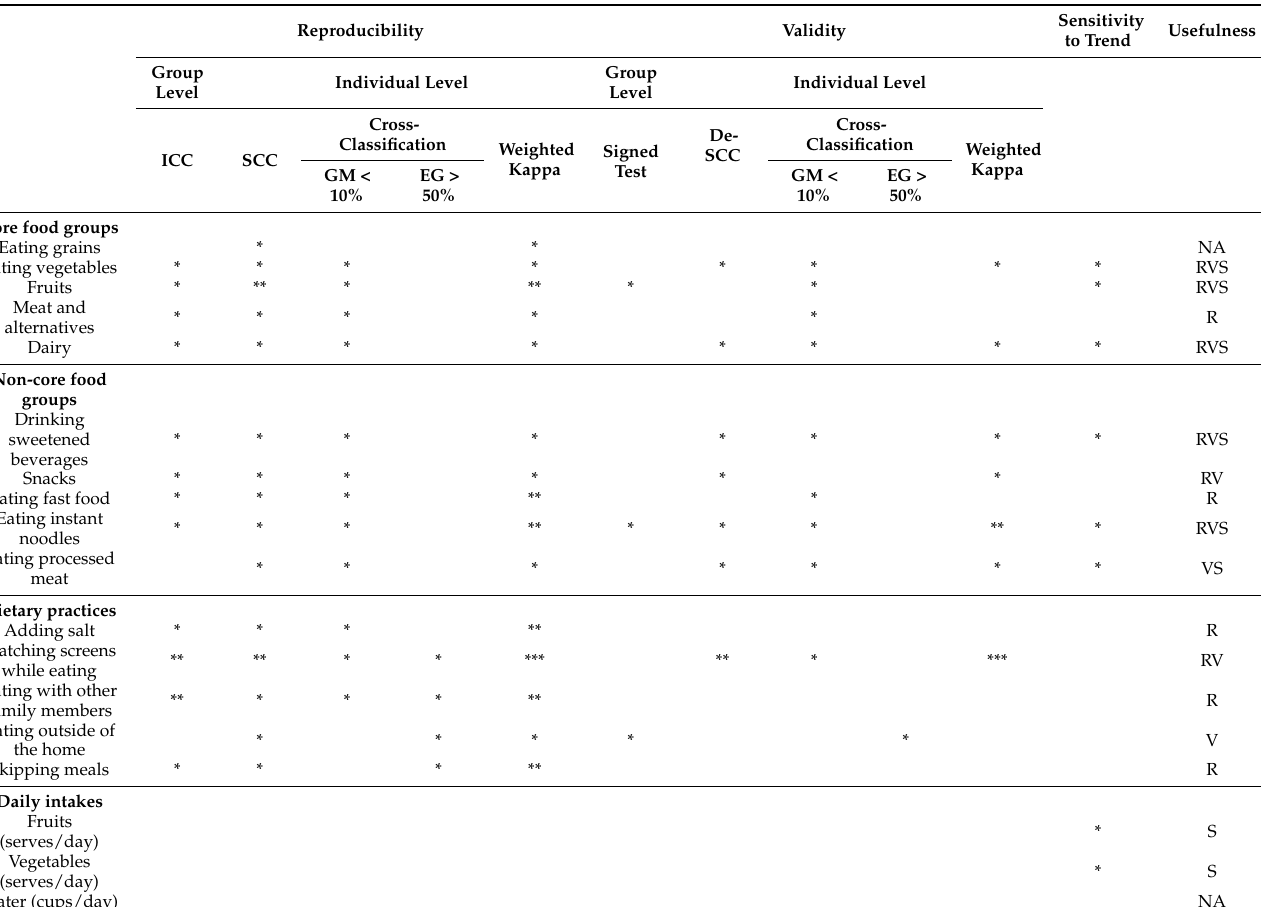
Table 8. Reproducibility, relative validity and sensitive to trend of each VCSDQ